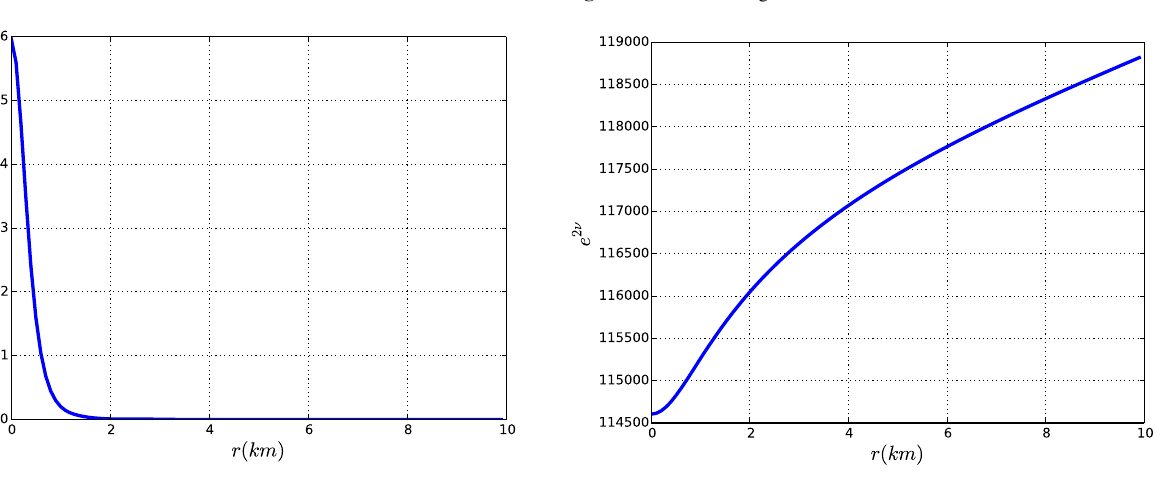
Fig. 5 Potential e 2 λ against radial distance r